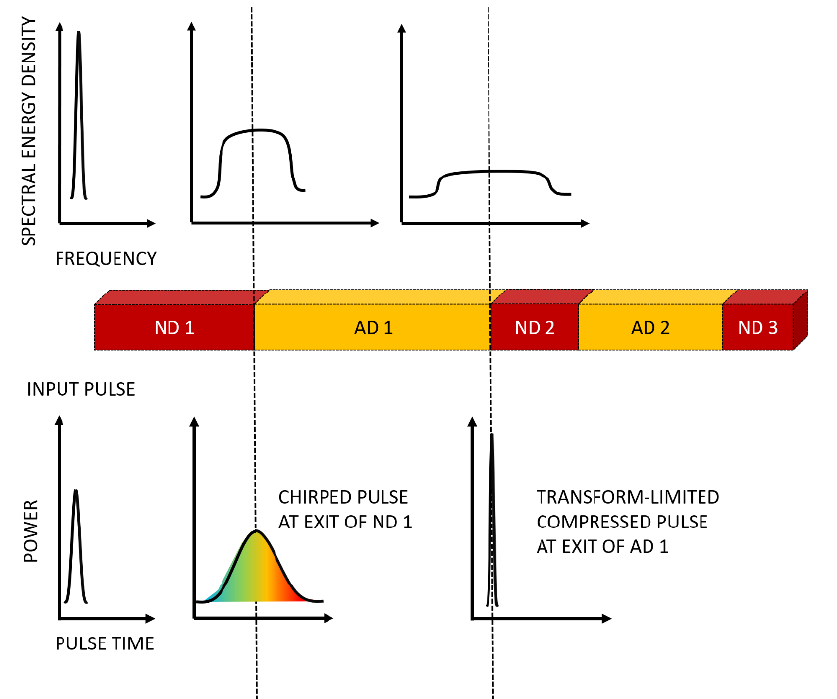
Figure 1. An illustrative example of spectrum and power dynamics of pulse across the first two segments in the sign-alternating dispersion waveguide structure for supercontinuum generation SCG and nonlinear pulse compression. The broadening and compression dynamics repeat (albeit with different values) for every cycle of normal dispersion (ND)—anomalous dispersion (AD) segments across the structure. The duration of the pulse decreases at the exit of every additional AD segment due to the ongoing bandwidth generation.